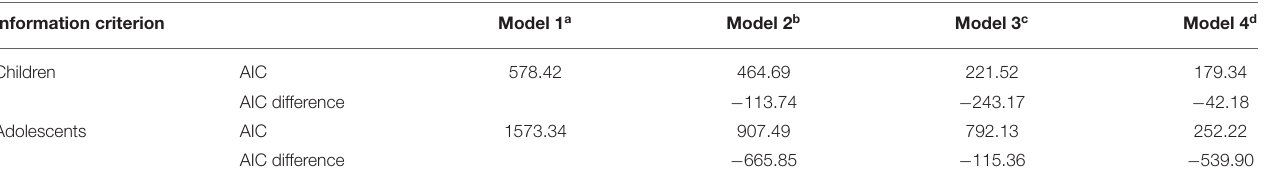
TABLE 2 | AIC and AIC